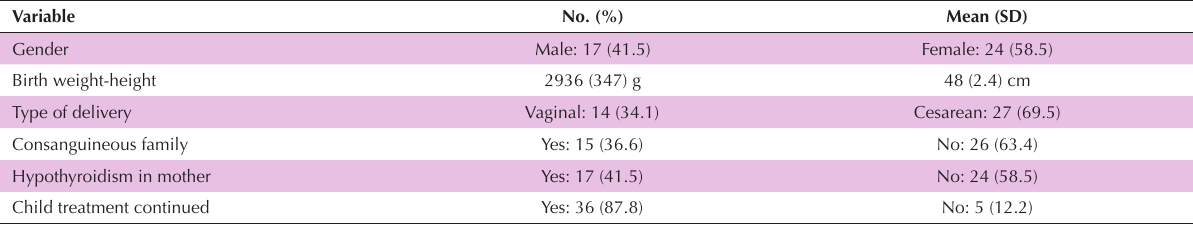
Table 2. General characteristics of study group (children with positive test for congenital hypothyroidism)